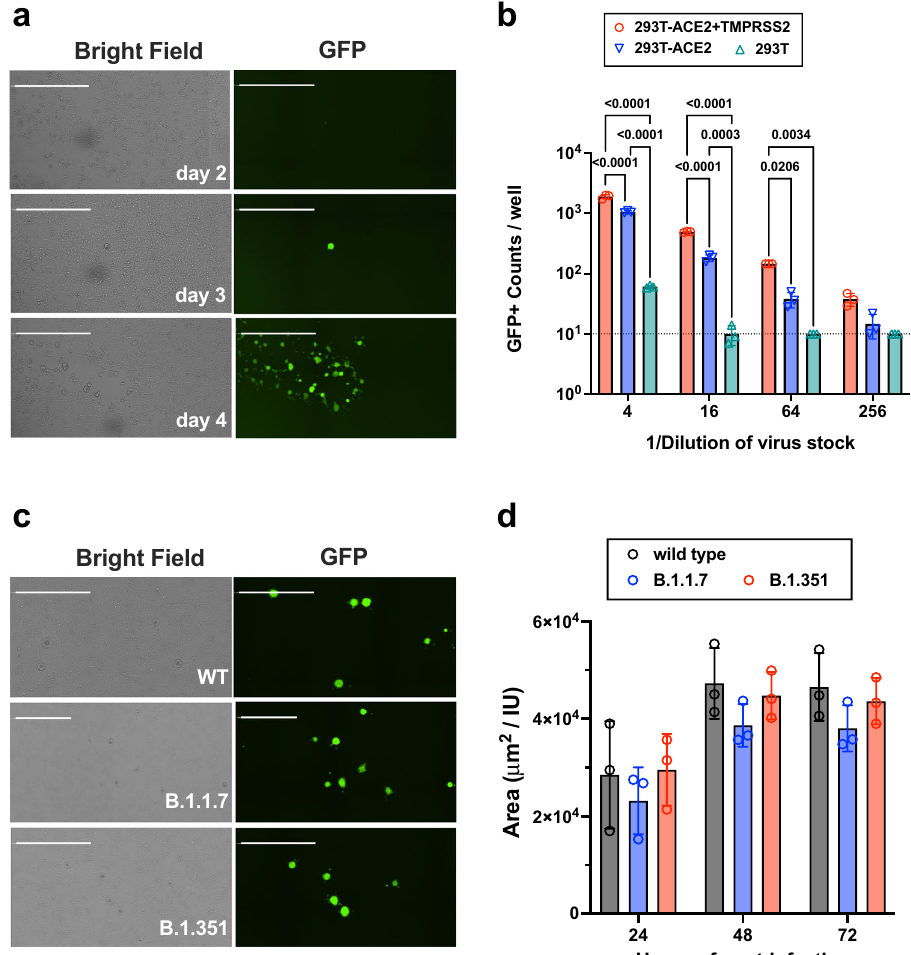
Fig. 1 Replication-competent VSV bearing wild-type and variant SARS-CoV-2 spike (rcVSV-CoV2-S). a De novo generation of rcVSV-CoV2-S, carrying an EGFP reporter, in transfected 293T-ACE2 + TMPRSS2 (F8-2) cells as described in Supplementary Fig. 1. Single GFP + cells detected at 2 – 3 days post-transfection (dpt) form foci of syncytia by 4 dpt. Images taken by Celigo imaging cytometer (Nexcelom) and are computational composites from the identical number of fi elds in each well. White bar equals 1 millimeter. Foci is representative of at least 5 independent rescues. b Entry ef fi ciency of rcVSV-CoV2-S in parental 293T, 293T-ACE2, or 293T-ACE2 + TMPRSS2 cells. Serial dilutions of virus stocks ampli fi ed on Vero-TMPRSS2 cells were used to infect the indicated cell lines in 96-well plates in triplicates. GFP + cells were detected and counted by the Celigo imaging cytometer at 10 h post-infection (hpi). Symbols are individual data points from triplicate infections at the indicated dilutions. Bars represent the average of three replicates with error bars indicating standard deviation. Adjusted p -values from a two-way ANOVA with Tukey ’ s multiple comparisons test are indicated in the graph. c rcVSV-CoV-2-S containing the prevailing WT (D614G) and VOC (B.1.1.7 and B.1.351) spikes were inoculated into one 6-well each of F8-2 cells (MOI 0.1) and subsequently overlaid with methylcellulose-DMEM to monitor syncytia formation. Representative images of syncytial plaques at 48 hpi are shown (out of three replicates per virus per timepoint). White bar equals 1 millimeter. d shows the growth of GFP + area per infectious unit (IU) in the six-well plate. GFP + areas were imaged and measured by the Celigo imaging cytometer at 24, 48, and 72 hpi. IU was checked at 10 hpi in the same well. GFP + area ( μ m 2 ) at the indicated timepoint was divided by the IU counted at 10 hpi to normalize for input. Bar shows the average of triplicate experiments with error bar indicating standard deviation. Symbols represent individual data points. No statistically signi fi cant differences were detected between WT and VOC spikes in the size of GFP + syncytia at any given time point (two-way ANOVA as above, “ ns ” not indicated in graph). Source data are provided as a Source Data fi